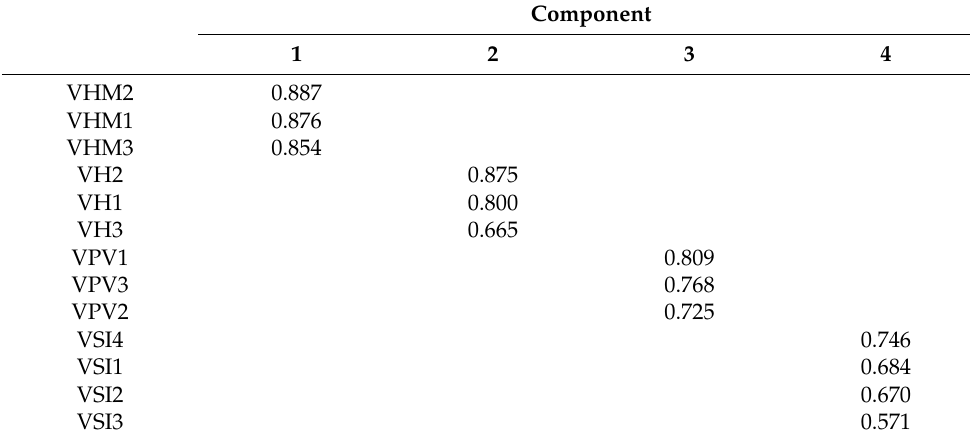
Table A3. Rotated component matrix for vlogging (for the purposes of distinguishing between the professions, a prefix ‘V’ was added to the item